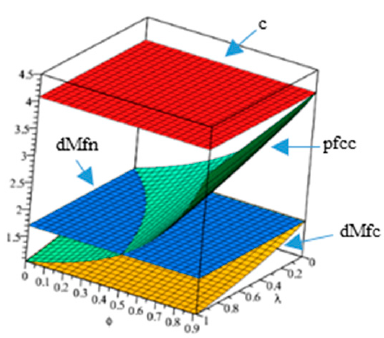
Figure 2. Effects of fairness concerns and profit-sharing on product green degree.